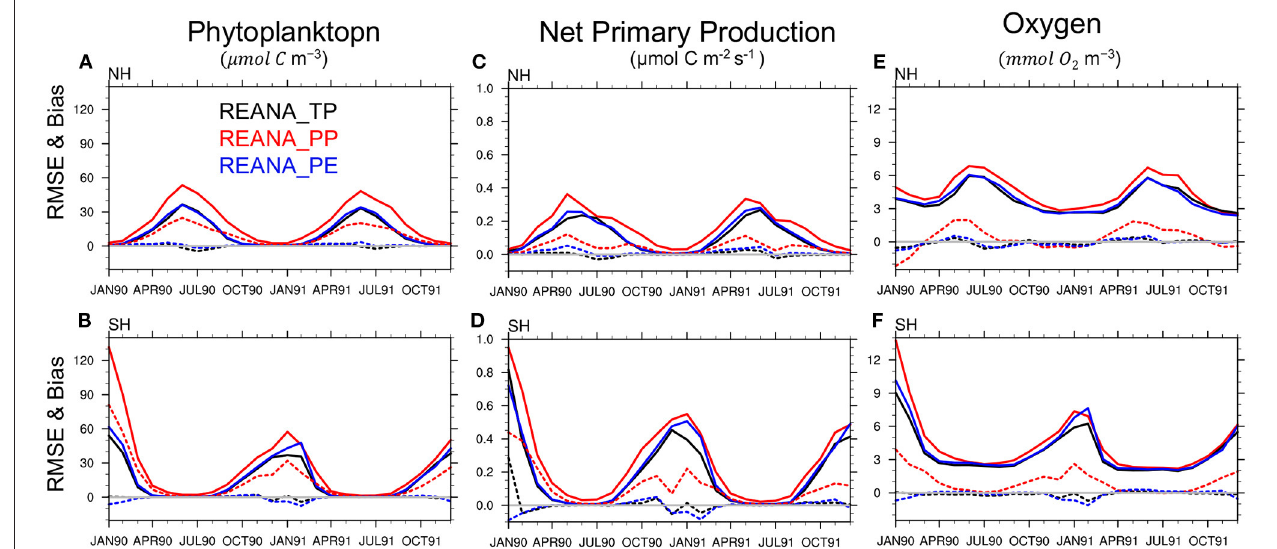
FIGURE 12 | Panels on the left show the RMSE (solid lines) and bias (dotted lines) of the ensemble mean of phytoplankton concentration reanalysis compared to the TRUTH in the euphotic zone in the northern hemisphere [NH, (A) ] and southern hemisphere [SH, (B) ]. The results of the reanalysis using TP are shown in black, PP in red, and PE in blue using assimilation of time-varying observations. (C,D) and (E,F) are same as (A,B) but for net primary production and oxygen concentration.